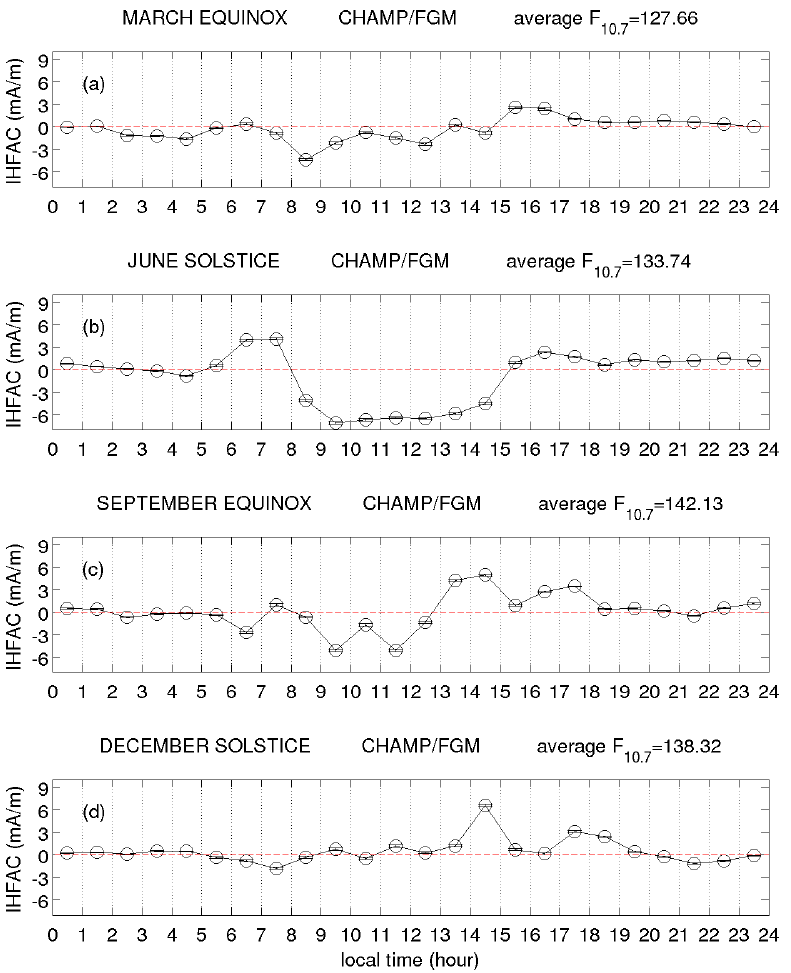
Fig. 2. Local time variation of IHFACs. Each panel corresponds to a season, with the average solar radio flux ( F 10 . 7 ) given in the headings. Positive values of IHFAC represent current flowing from north to south. The standard error of the mean is below 0.2mAm − 1 for each point due to the large number of observations (7600–21000 per